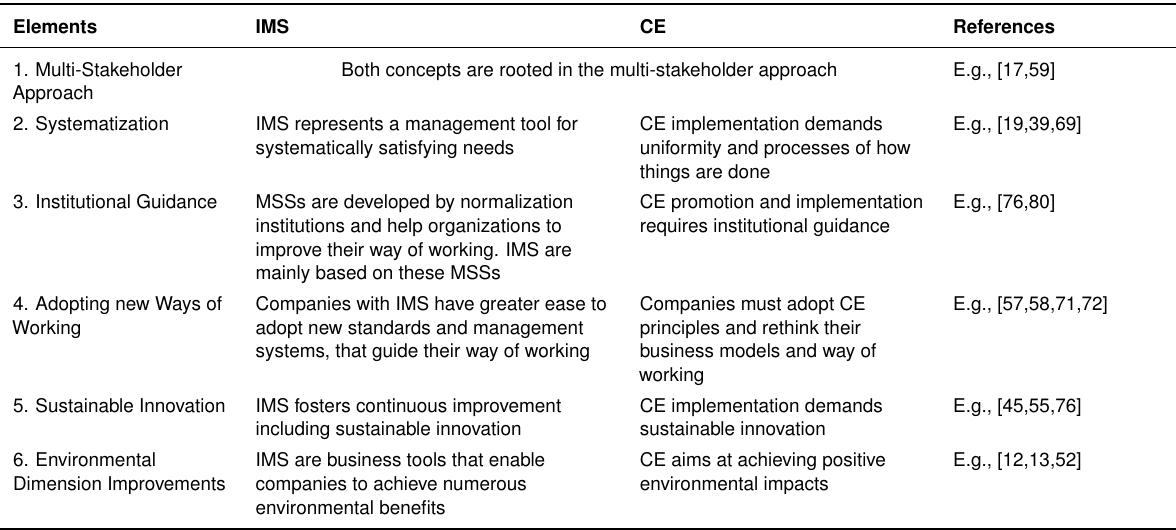
Table 1. Common Elements between Circular Economy and Integrated Management Systems.